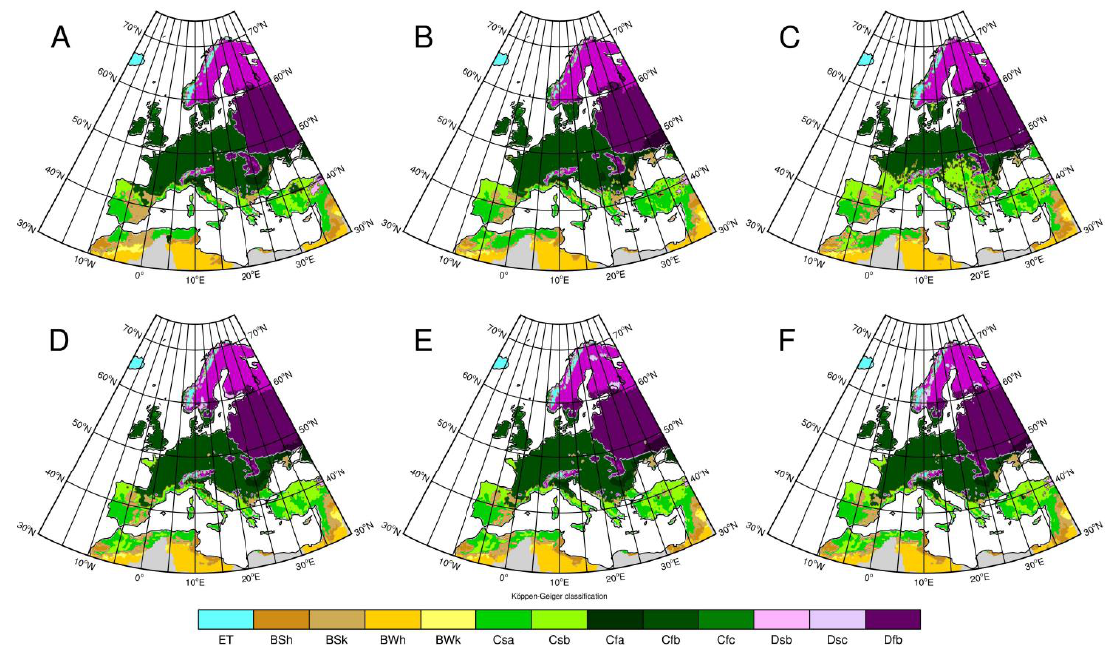
Figure 7. Simulated K-G climate classification according to E-OBS ( A ) and eQM corrected precipitation and temperature with 90-day moving window in ALADIN ( B ), HIRHAM ( C ), RegCM ( D ), RAMCMO2 ( E ) and RCA ( F ) in the test period in 1981 − 2000.